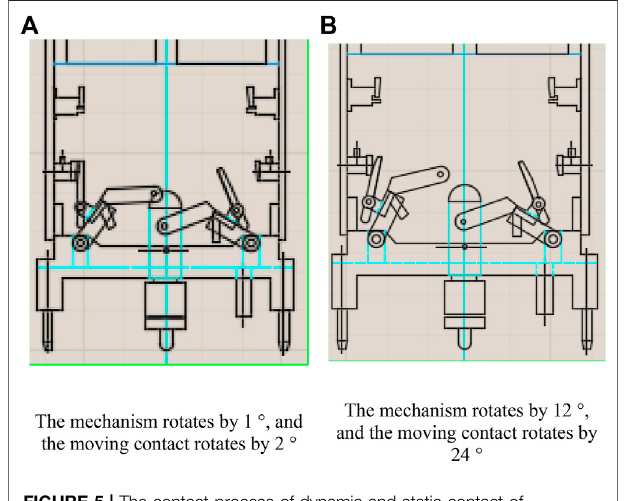
FIGURE 5 | The contact process of dynamic and static contact of transition contact. (A) The mechanism rotates by 1 ° , and the moving contact rotates by 2 ° . (B) The mechanism rotates by 12 ° , and the moving contact rotates by 24 °